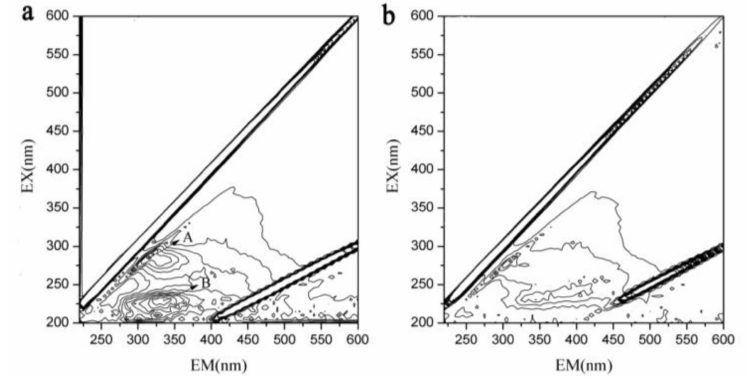
Figure 3. 3D-EEM of the e ffl uent from: ( a ) Reactor 1; and ( b ) Reactor 2.